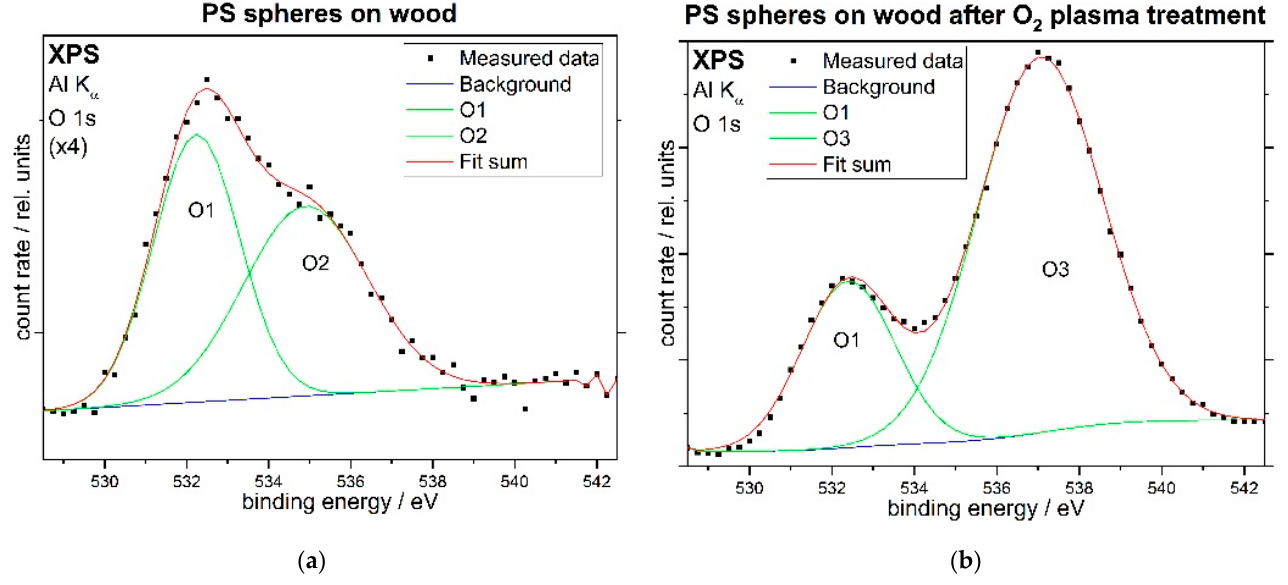
Figure 6. XPS O 1 s spectra of the PS sphere coated pine wood sample before ( a ) and after O 2 plasma treatment ( b ).